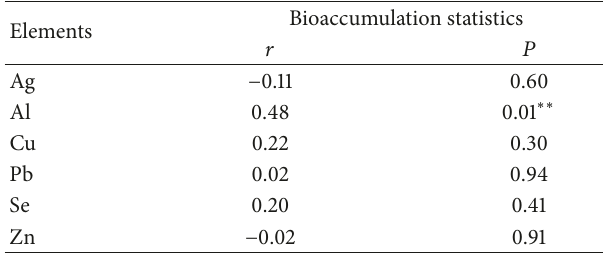
Table 3: Correlations reported with correlation coefficients ( r ) and P values ( P ) between ECM root colonization and bioaccumulation of elements from eight-year-old chestnut trees (tree type pooled, 𝑛 = 24 ). Asterisks ( ∗∗ ) indicate differences at